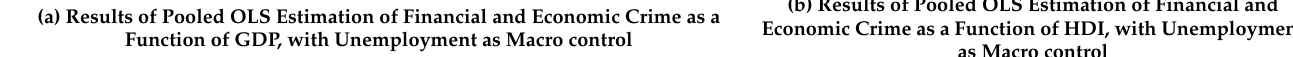
Table 3. Simple regression modeling—Robustness checks (2), with Unemployment.